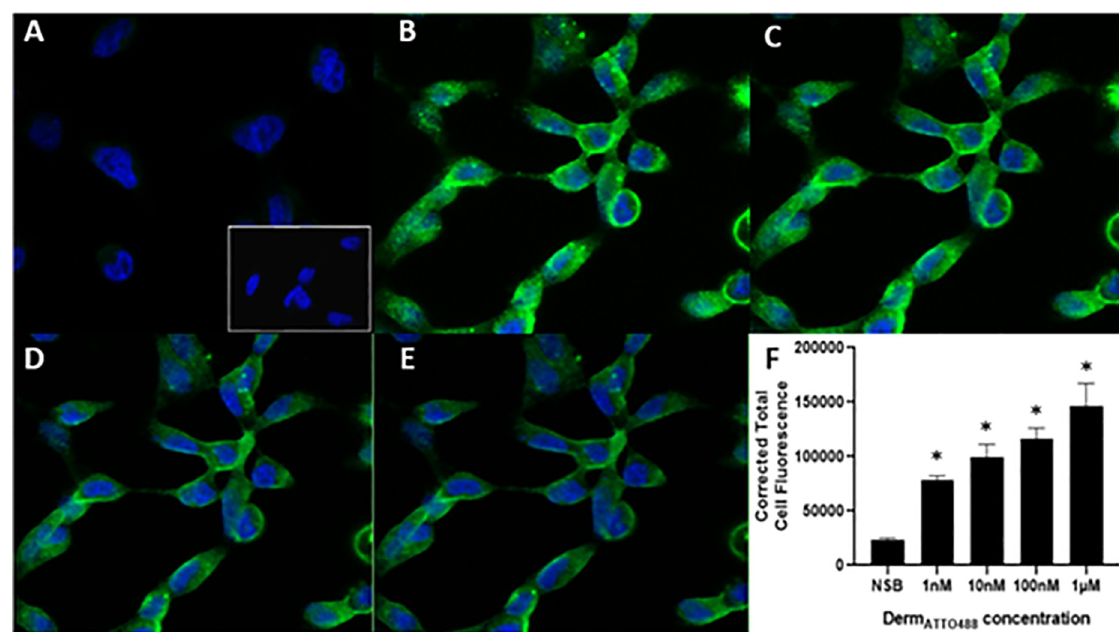
Fig 4. Concentration-dependent binding of Derm ATTO488 to MOP receptors expressed in HEK cells using confocal microscopy. Representative images of the binding of various concentrations (B: 1 μ M, C: 100nM, D: 10nM and E: 1nM). Nuclei are labelled (blue) with DAPI. Unlabelled (25 μ M) Dermorphin blocked the binding of 1 μ M Derm ATTO488 (16%) to the MOP receptors (A). Untransfected cells labelled 1 μ M Derm ATTO488 are depicted in A-inset. Image F shows mean corrected total cell fluorescence ± SEM for n = 5 experiments and � p < 0.05 compared to NSB according to ANOVA followed by Dunnett’s test for multiple comparison.